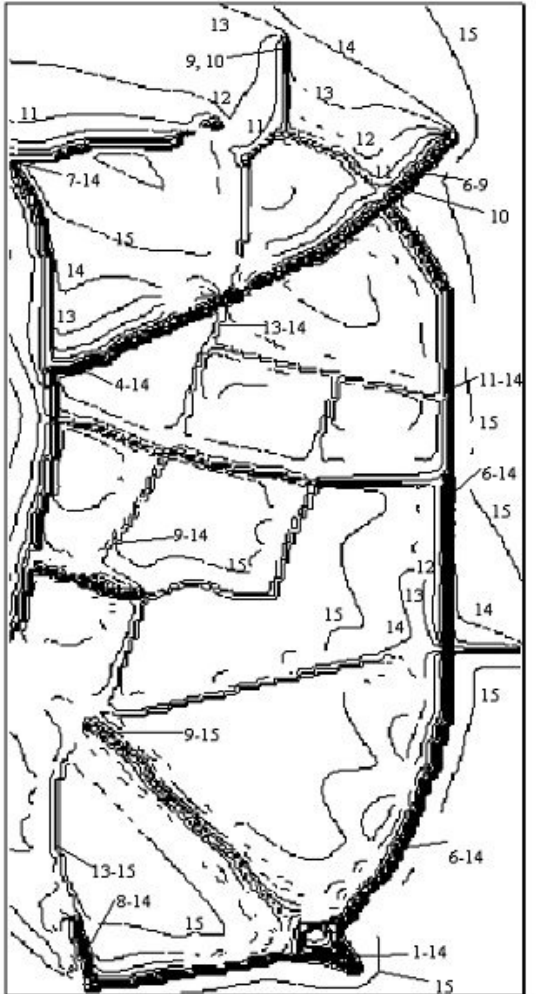
Fig. 4. Scatter of CO then wind blows from the